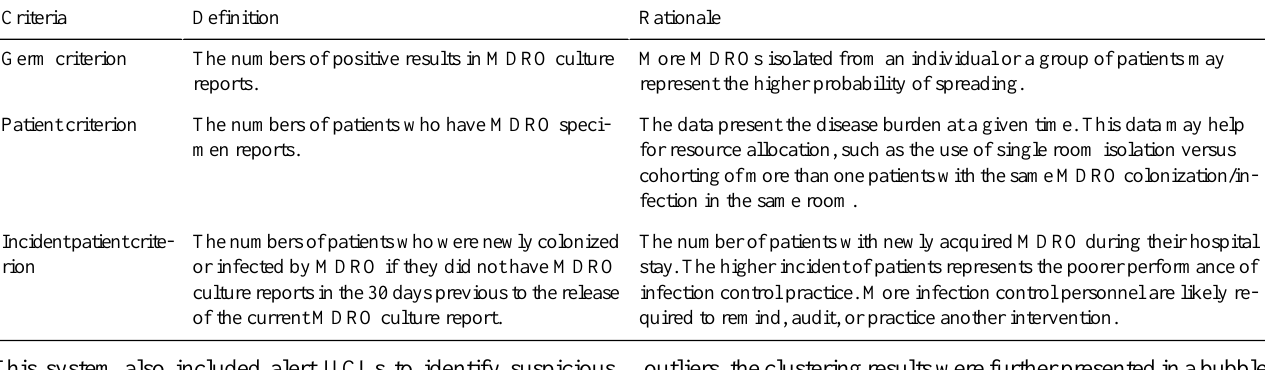
Table 1. The definition and rationale of three counting criteria for multidrug-resistant organism surveillance and outbreak detection system. RationaleDefinitionCriteria